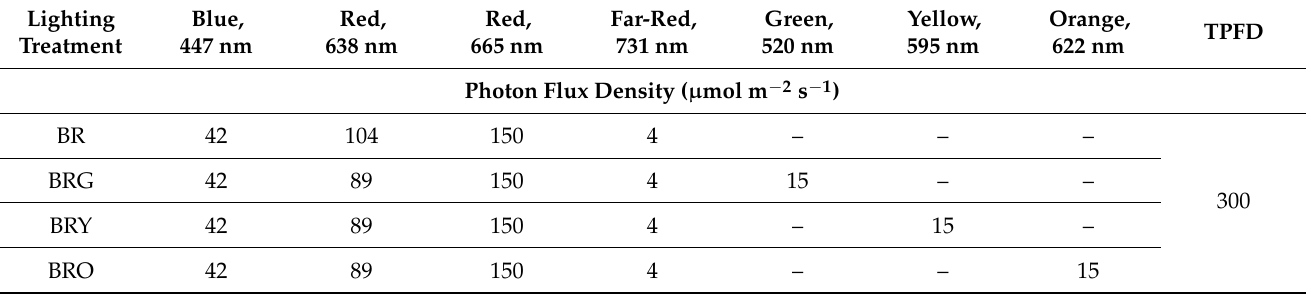
Table 1. Photon distribution of sole-source lighting for four lighting treatments used in experiments. Lighting